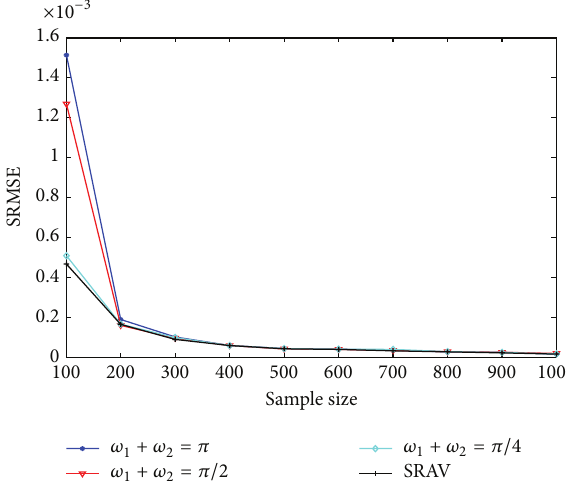
Figure 2: Plot of the SRMSEs for Model 1 to Model 3 as well as the SRAVs for different sample sizes when 𝜎 2 0 = 0.5 .